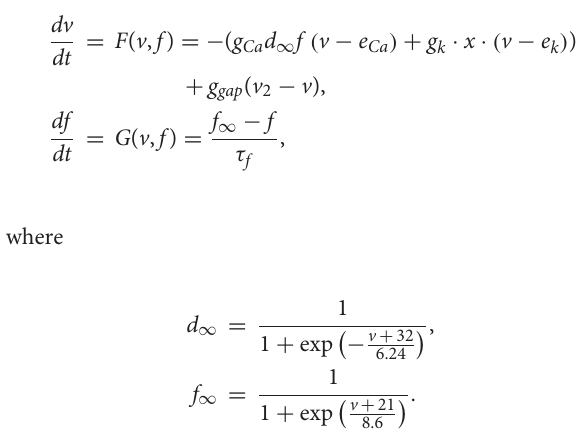
145.6 µ A/ µ F. The maximum APD is 341ms. (D) a graph of APD =